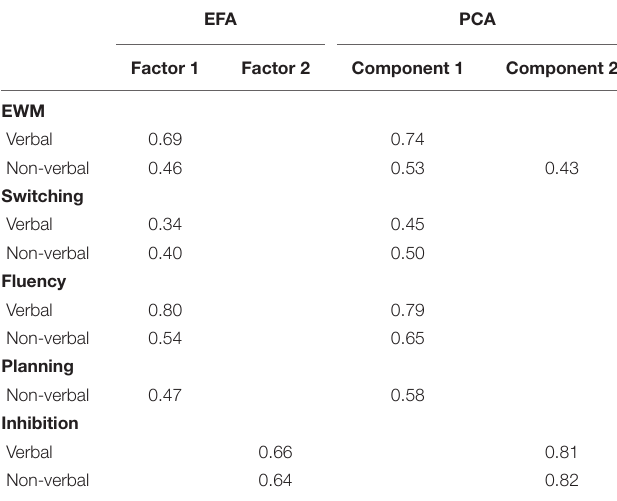
TABLE 4 | Pattern matrix for exploratory factor analyses (EFA; oblique rotation) and principal components analyses (PCA; varimax) on assessments of EWM, switching, inhibition, fluency, and non-verbal